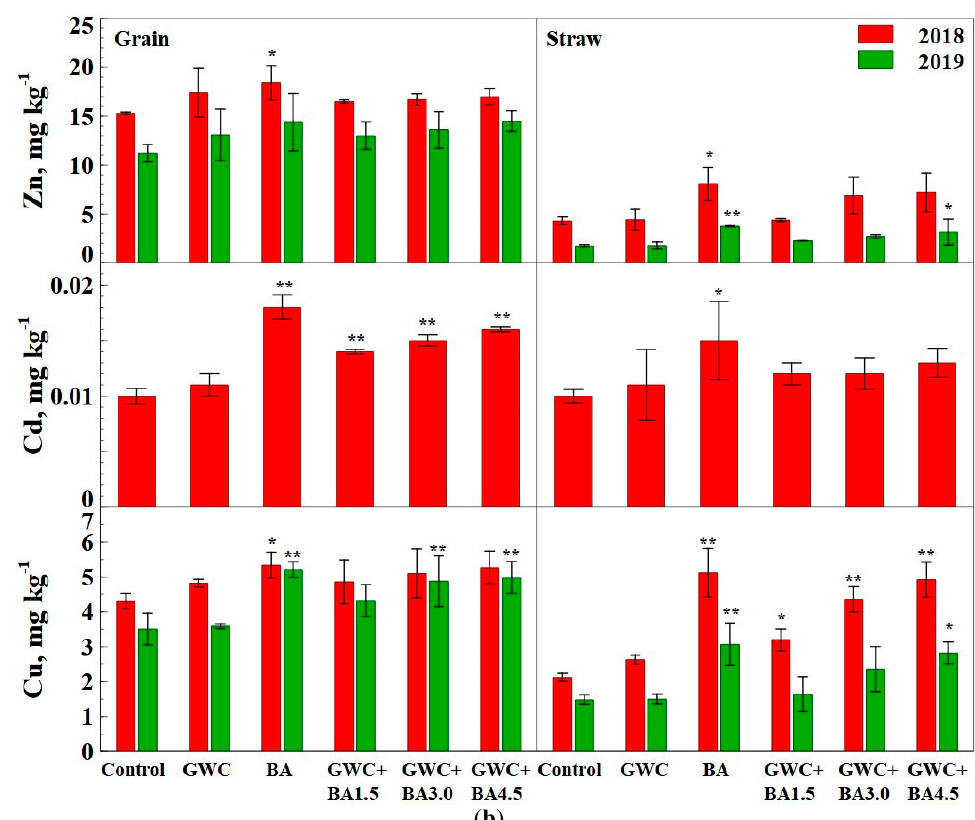
Figure 5. ( a ) Nutrient and ( b ) heavy metals concentration change in spring wheat (2018) and spring triticale (2019) grain and straw after fertilization with BA, GWC, and the GWC + BA mixture. * = significance at p ≤ 0.05 and ** = significance at p < 0.01. BA—biofuel ash; GWC—green waste compost; GWC + BA1.5—green waste compost (20 t ha − 1 ) + biofuel ash (1.5 t ha − 1 ); GWC +